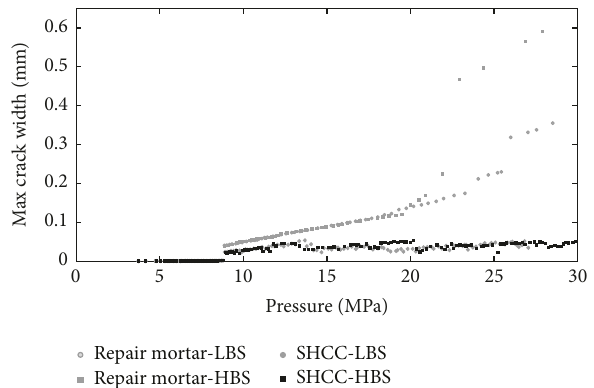
Figure 21: Pressure build-up and corresponding maximum crack widths in the system with the substrate stronger than the repair material (LBS corresponds to the interface strength of 1MPa and HBS to the interface strength of 3 MPa).